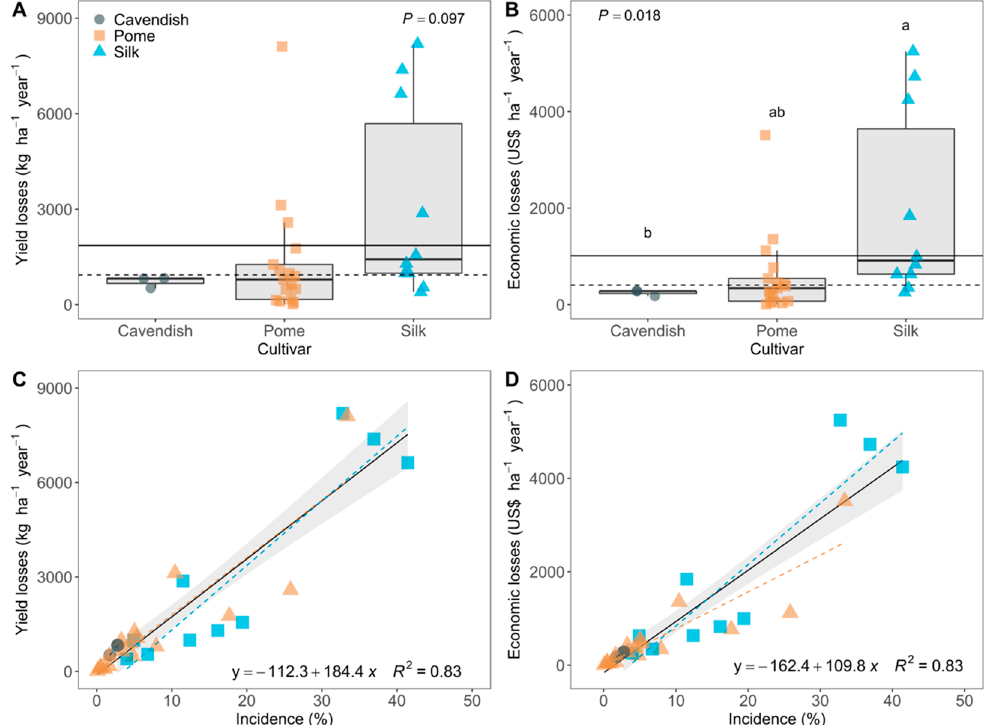
Figure 2. Estimated values of yield and economic losses and its relationship with the incidence of Fusarium wilt of banana assessed in 30 fields from different cultivars and regions of Brazil. ( A) Frequency of estimated values of yield losses, and ( B ) economic losses by cultivar. Estimated values for each assessed field (symbols) and overall regression (solid black) and cultivar regression lines (dashed colored) for the relationship between FWB incidence and ( C ) yield losses, and ( D ) economic losses. Confidence intervals (CI95%) is presented in C and D as shaded areas.